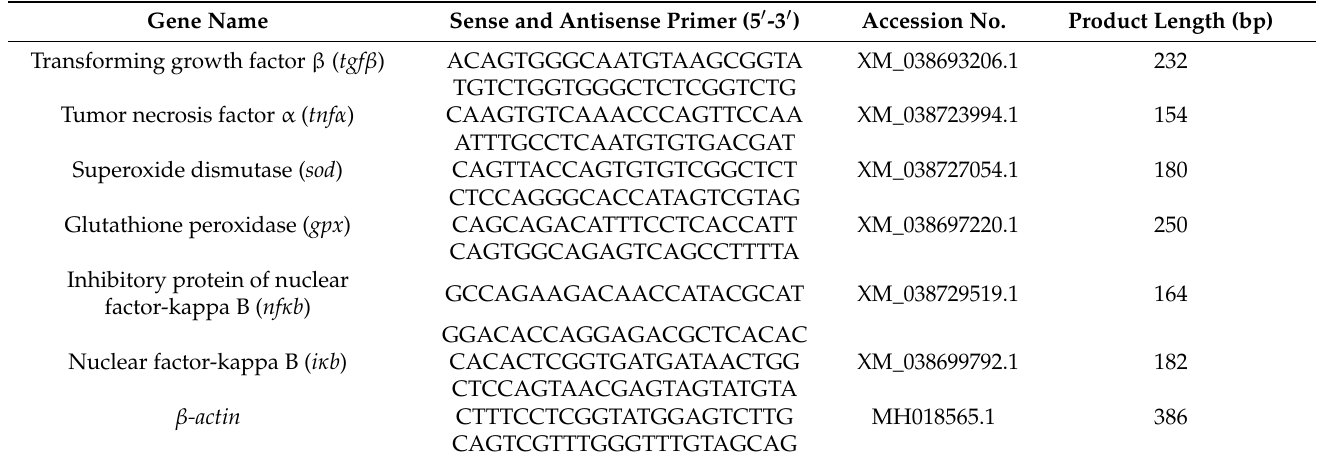
Table 2. Primers used in this